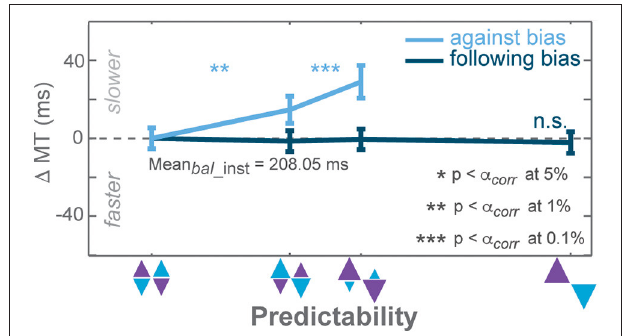
FIGURE 5 | Responses ofCP-biasedsubjects inAMNTtask.(A) Choice probabilities,and (B) averagechoice RTdifference (zeroline indicates average RTsininstructed trials ofzero-biascondition)in allbiaslevels.Darkandlight colorsrepresent follow and against responses,respectively.Theerrorbarsdepict standarderrors.( * p < α corr at5%, ** p < α corr at1%, *** p < α corr at0.1%).